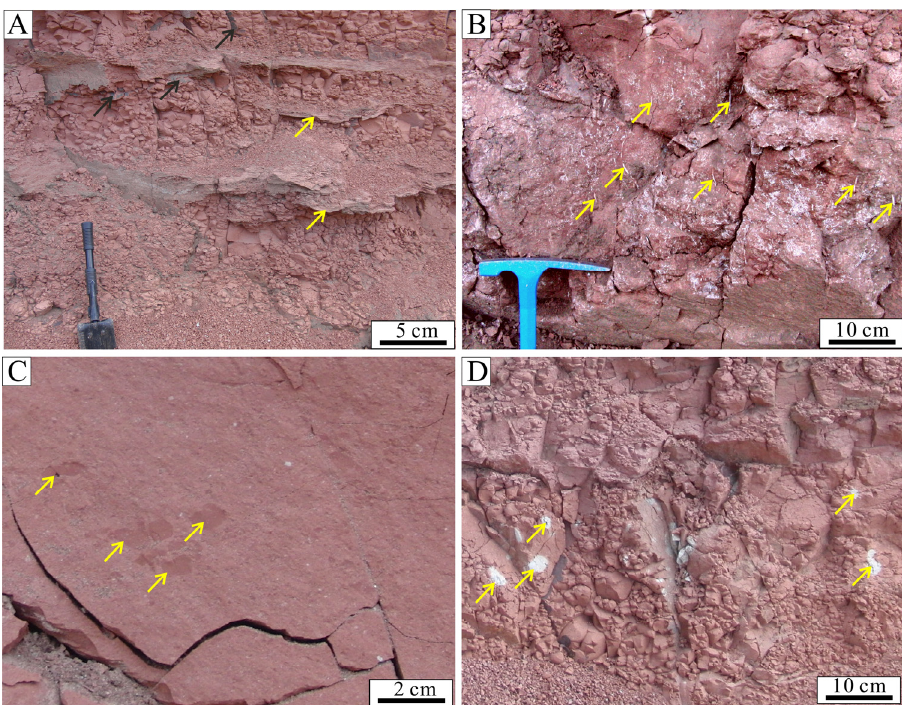
Figure 4. Photographs showing paleosol details in mudflat deposits of the Yaojia Formation. ( A ) Concrete beds in paleosols of facies 2 (marked with yellow arrows) and manganese cutans (marked with black arrows) in paleosols. ( B ) Rhizoliths marked with yellow arrows in red paleosols. ( C ) Mud clasts in the red silty mudstone ( D ) Mottles marked by yellow arrows in the red paleosols.